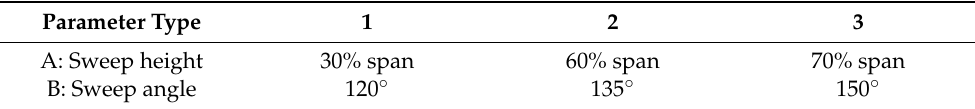
Table 1. Modeling scheme for blade sweep.